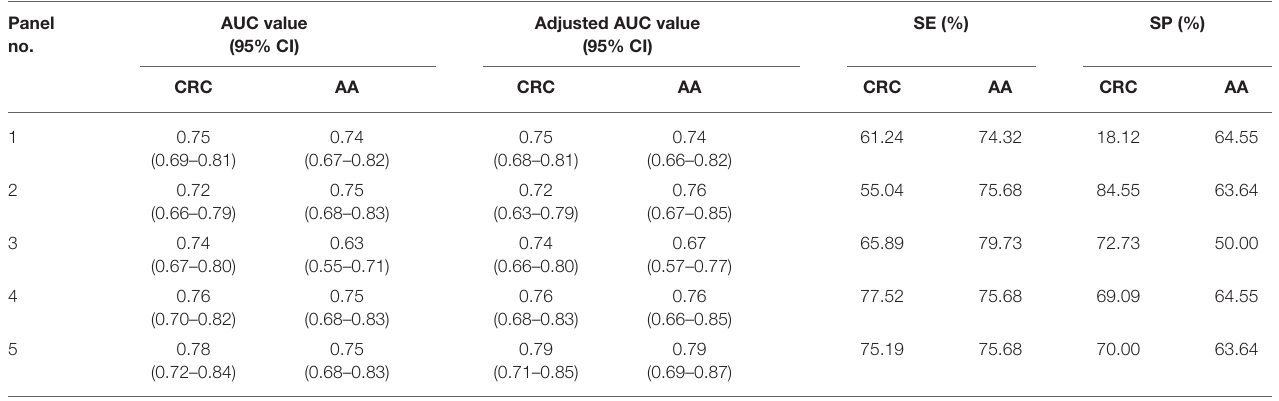
TABLE 2 | Detection performance of multiple tumor-associated autoantibodies determined by ELISA. Panel no.